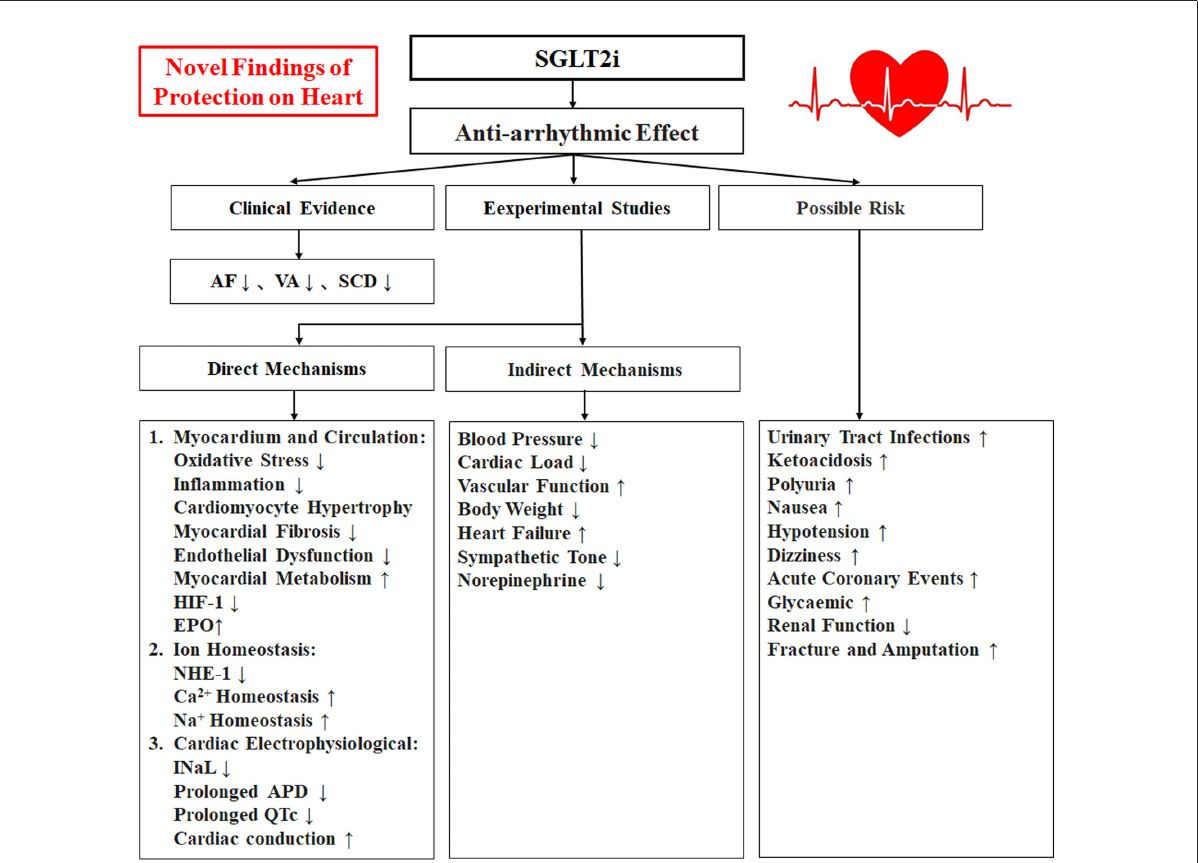
FIGURE1 A schematic illustrating the relationship between the SGLT2i with antiarrhythmic effects and Mechanism. SGLT2i, Sodium-glucose cotransporter 2 inhibitors; AF, atrial fibrillation/atrial flutter; VA, ventricular arrhythmias; SCD, sudden cardiac death; HIF-1, hypoxia-inducible factor-1; EPO, erythropoietin; NHE-1, Na + -H + exchanger 1; INaL, late Na + current; APD, action potential